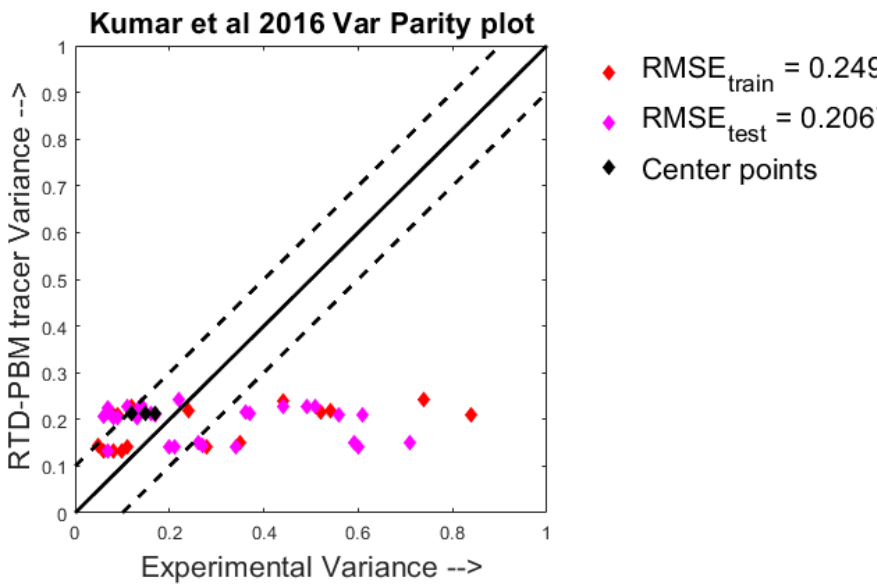
Figure 5. Experimental observations (X) vs. predicted model responses (Y) for the Variance when the model is trained on the Kumar et al., 2016 [19] dataset without including the dispersion flow rates. From Figure 6, it is seen that the model size predictions for the fine granules center lie on the Y = X line, thereby giving a reasonably good